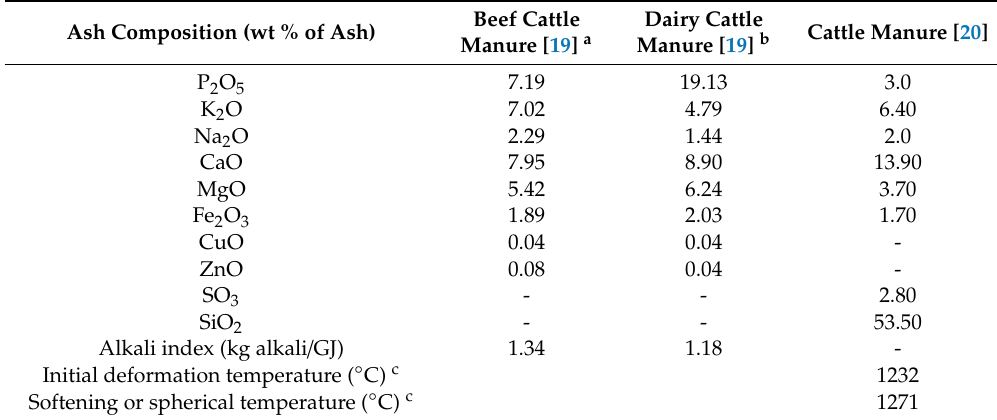
Table 1. Ash composition of manure, alkali index and melting behaviour. Ash Composition (wt % of